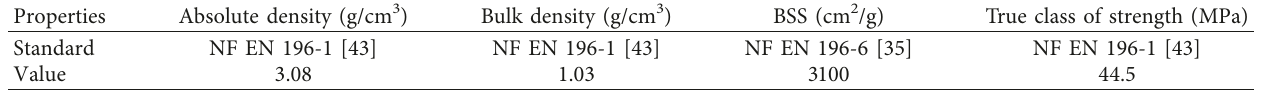
Table 4: Physical and mechanical properties of cement.